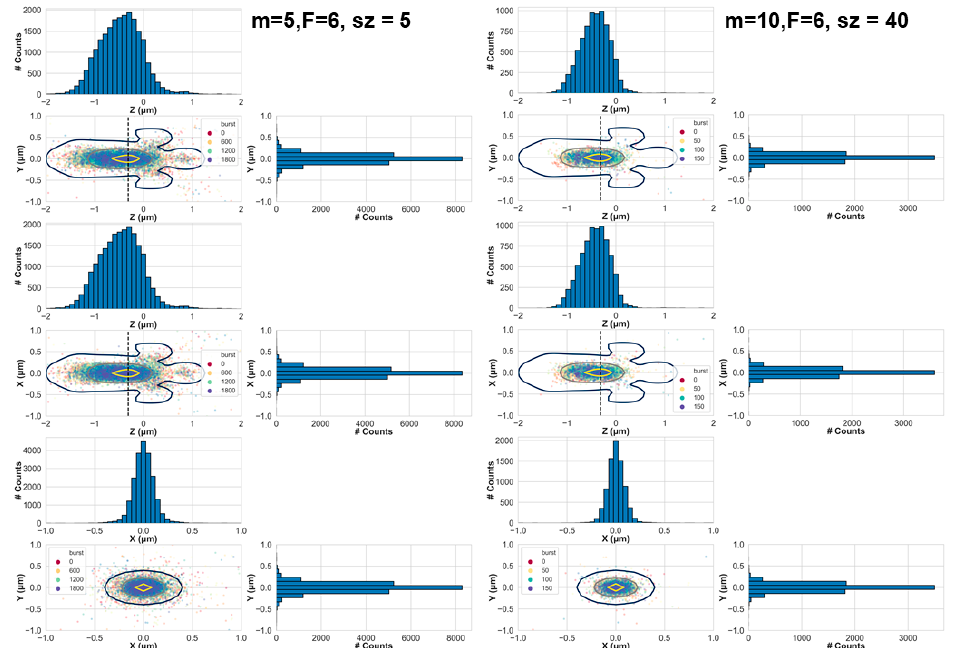
Figure 2. The positions of diffusing molecules when they emitted photons that were detected and selected by the burst analysis, either with minimal burst analysis parameter values ( m = 5 and F = 6; left panels) or with stringent burst analysis parameter values ( m = 10, F = 6 and burst size threshold, sz = 40; right panels). In the top, central, and bottom panels we show the 2D projections at the yz, xz, and xy planes, respectively. Each dot in the scatter plots is an emitted photon. These results are for the simulation of molecules in a concentration of 62 pM, where the diffusion coefficient of the molecules was 90 μ m 2 /s. The colors of the points correspond to the burst number out of the overall number of bursts. In each panel, the 1D projections are also shown as histograms. The black, brown, and yellow contour lines align the position of the numerical PSF model (see shapes of PSF models in Figure 1).